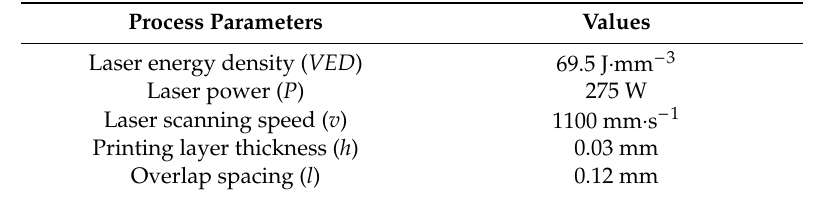
Table 1. Selective laser melting parameters.